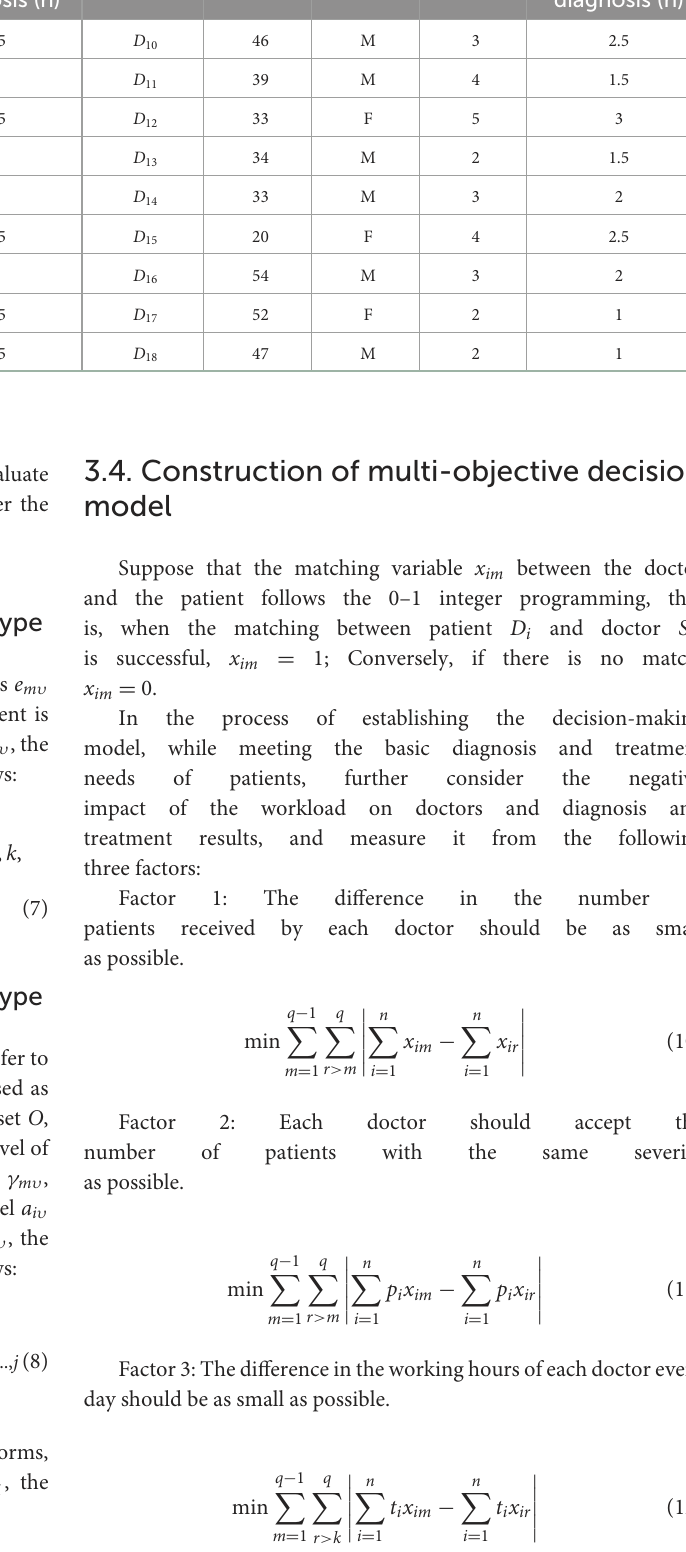
TABLE 1 Characteristic information of patients. Patient number